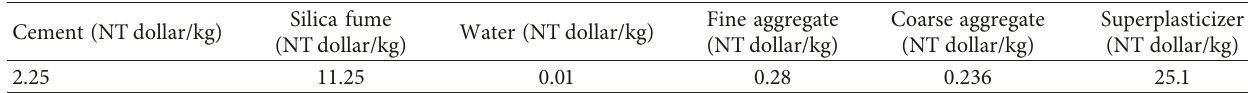
Table 6: Unit cost of the concrete components [9].